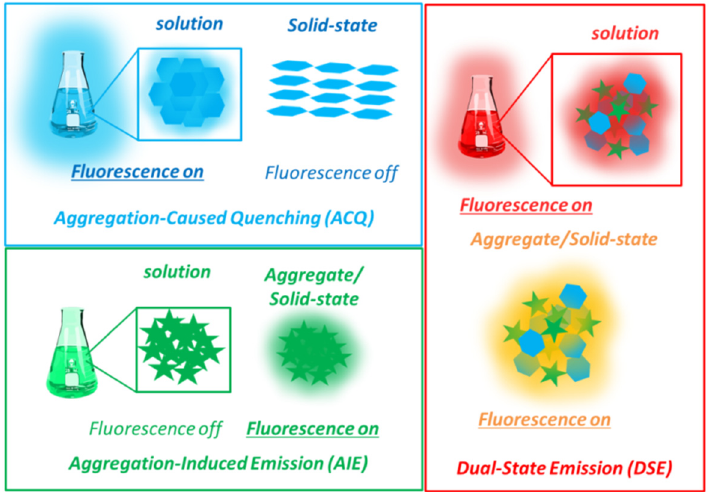
Figure 1. Schematic representations of the concepts of aggregation-caused quenching (ACQ), aggregation-induced emission (AIE) and dual-state emission (DSE).